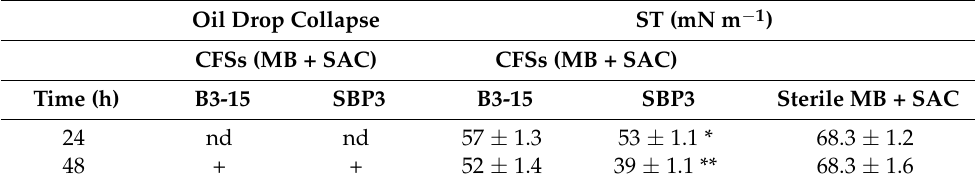
Table 4. Surface activities of (CFSs (MB + SAC) from B3-15 and SBP3 strains, using the oil drop- collapse and ST assays. Data are expressed as averages and standard deviations (n = 3). * Significantly different ( p < 0.05); ** ( p < 0.01).